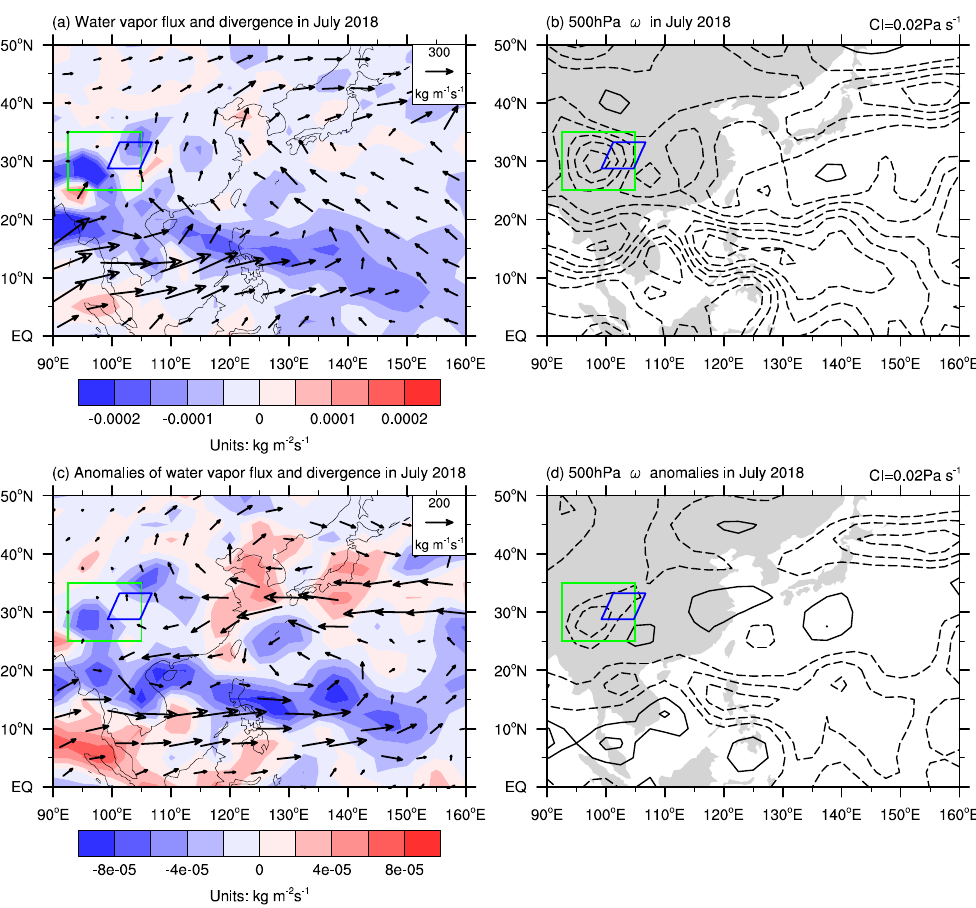
Figure 3. The ( a ) column-integrated water vapor flux (vector, unit: kg m − 1 s − 1 ) and its divergence (shading, SI = 5 × 10 − 4 kg m − 2 s − 1 ) and ( b ) the 500 hPa omega [contour interval (CI) = 0.02 Pa s − 1 ] in July 2018; ( c , d ) are the same as ( a , b ), but for the anomalies in July 2018. The blue parallelograms are the same as those in Figure 1a,b. The green rectangles indicate the region to calculate the omega in Figure 1c.